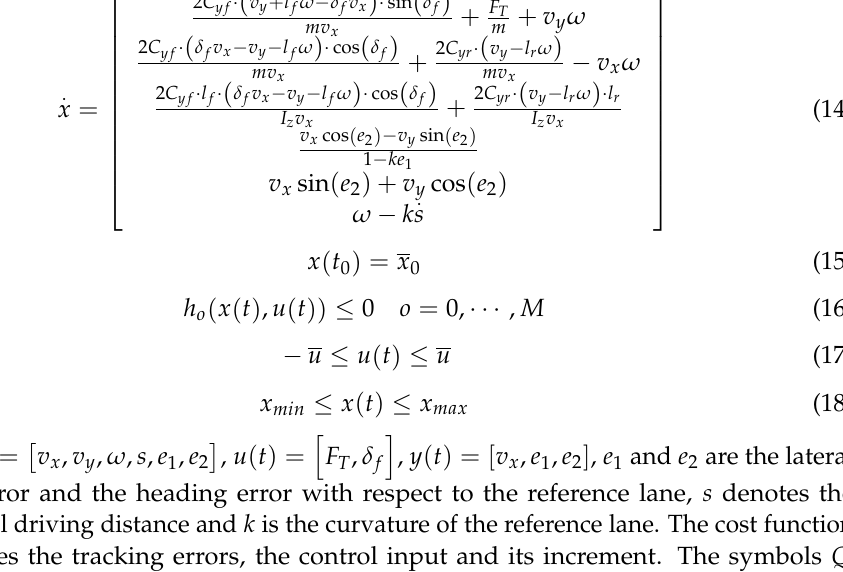
Table 2. Parameters of NMPC motion planner. Symbol